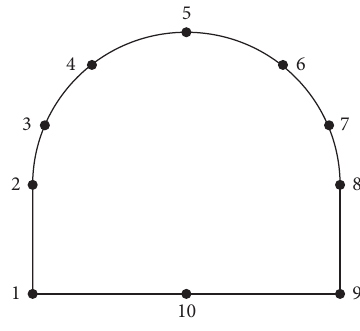
Figure 4: Monitoring stations